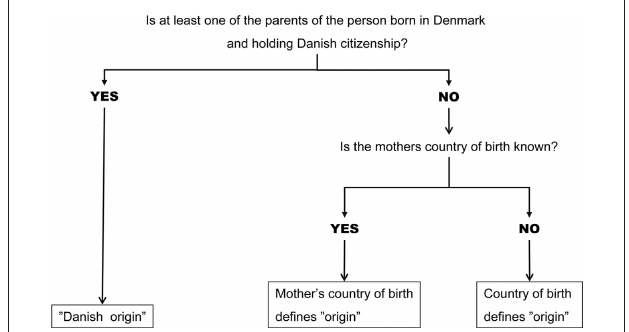
FiguRe 1 | Construction of “country of origin” as ethnicity proxy. “Country of origin” was based on the parent’s country of birth for a given subject. If one of the parents was born in Denmark and hold Danish citizenship, the person was classified as being of “Danish origin.” When a person is identified as being of “non-Danish origin,” the country of birth of the mother defines the person’s “country of origin.” If data about the mother is not available in the national Danish registry, the country of birth of this person is taken as “country of